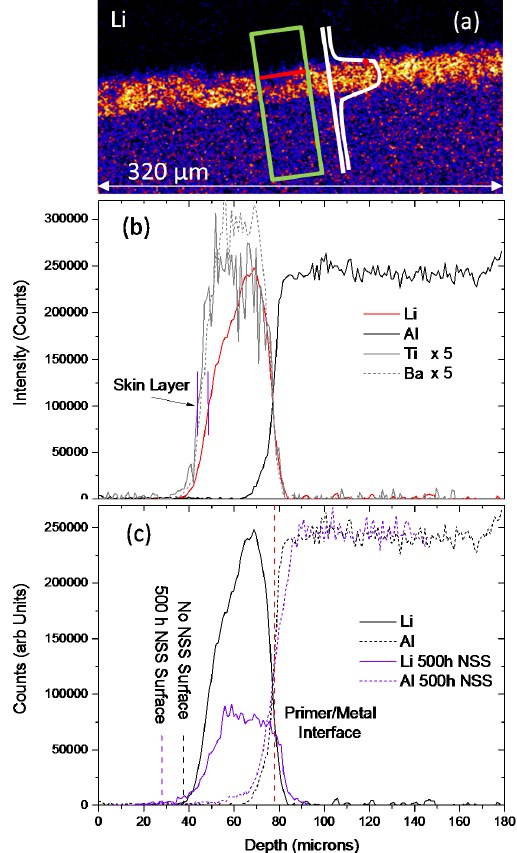
Figure 13. Traverse elemental profiles. ( a ) Example of a traverse profile where a region is chosen for the profile (green box) and individual elemental intensities are averaged along a line (red line) to produce a point on a line profile (red point). ( b ) Profiles for Ti (PIXE), Ba (PIXE), Li (PIGE) and Al (PIGE) across the without NSS. Ti and Ba signals are multiplied by five to show the skin layer. ( c ) PIGE profiles for Al and Li without salt spray and after 500 h NSS. Note the thickness of the coatings are different and the surface is indicated by markers. The 500 h NSS results have been adjusted so that the Al intensity from both conditions is the same, thus allowing qualitative comparison between the two Li profiles.